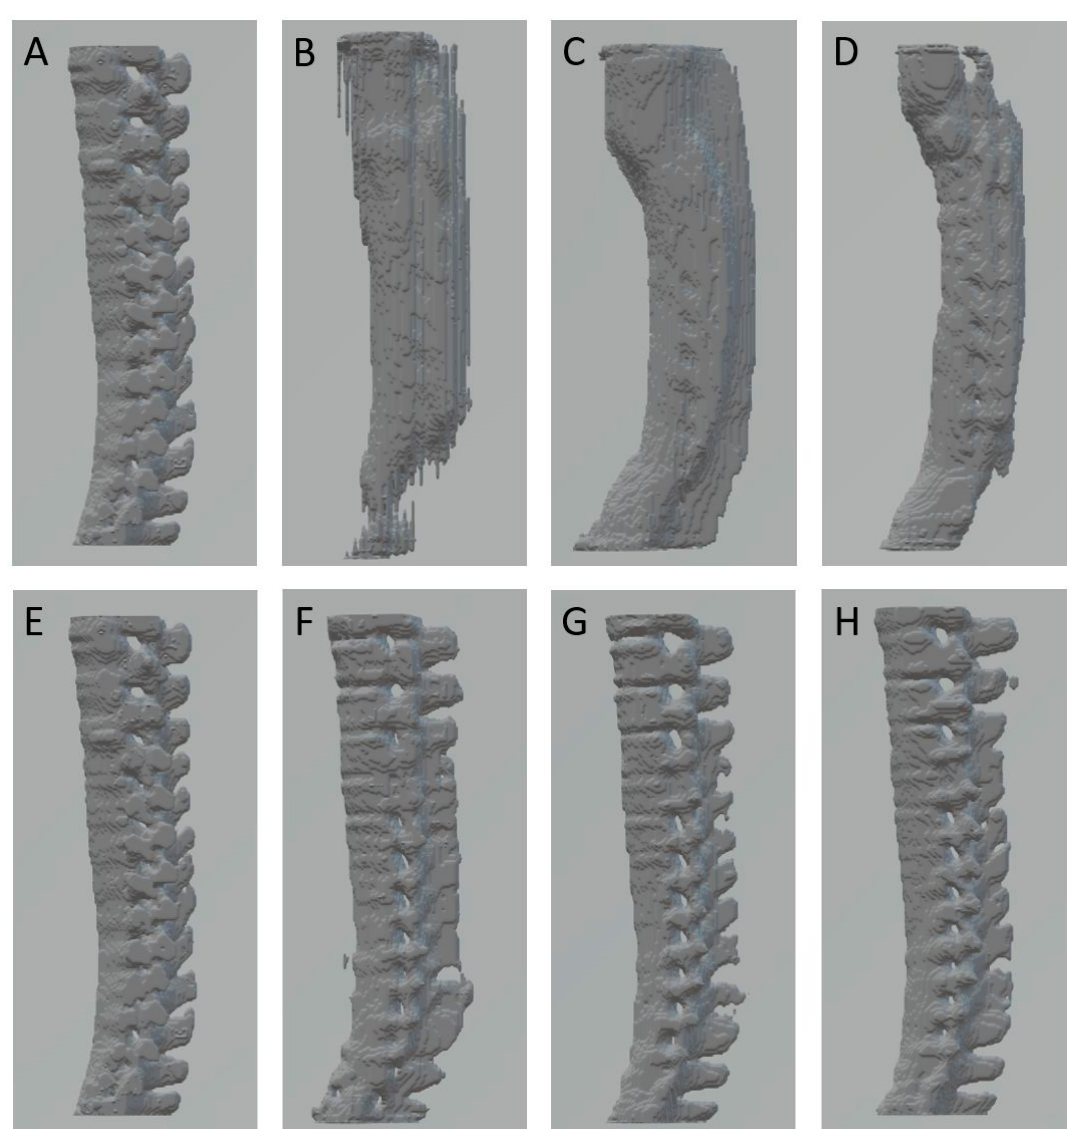
Figure 7. ( A , E ) GT spine; ( B ) Ori_333, DSC: 0.6605, SSIM_AP: 0.8293, SSIM_Lat: 0.8329; ( C ) Ori_666,